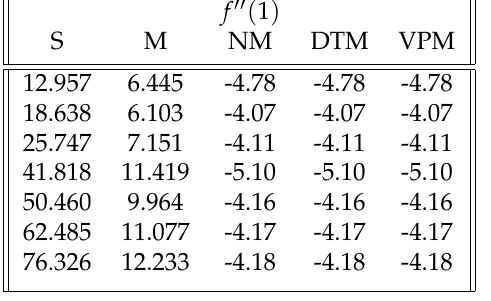
Table 5. Comparison of results for small squeezing number in the absence of magnetic field